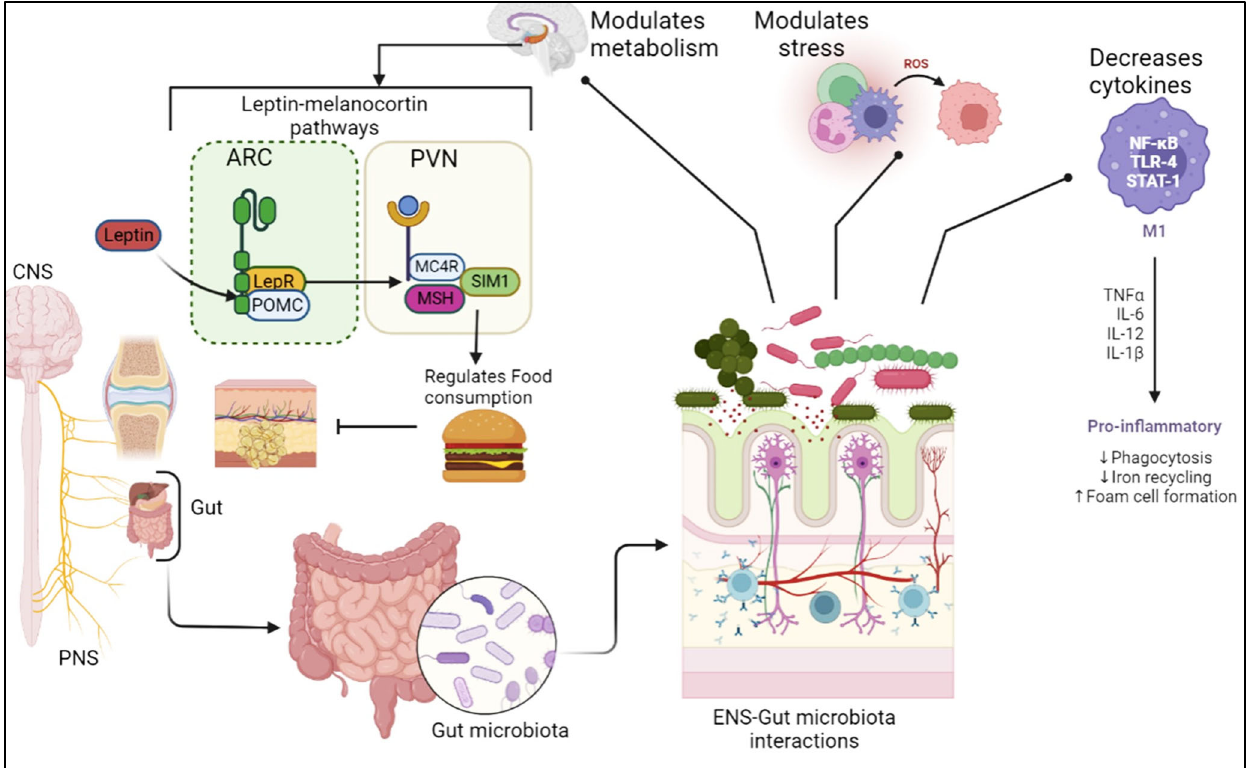
Figure 2. Diagrammatic illustration of leptin–melanocortin signaling pathway. The leptin ‐ melano ‐ cortin pathway is crucial in energy homeostasis by acting as a link by which information about energy status can be relayed to the CNS to control food intake and energy expenditure. LepR, leptin receptor. SIM1, single ‐ minded 1. ARC, arcuate nucleus of the hypothalamus. POMC, proopiomelanocortin. MC4R, melanocortin ‐ 4 receptor. PVN, paraventricular nucleus of the hypo ‐ thalamus. MSH, melanocyte ‐ stimulating hormone. POMC neurons in the ARC when activated by leptin produces α‐ MSH, which in turn activates MC4R which produces a satiety signal. The gut microbiota is also known to modulate stress, cytokines, proinflammatory activities and the CNS metabolism.